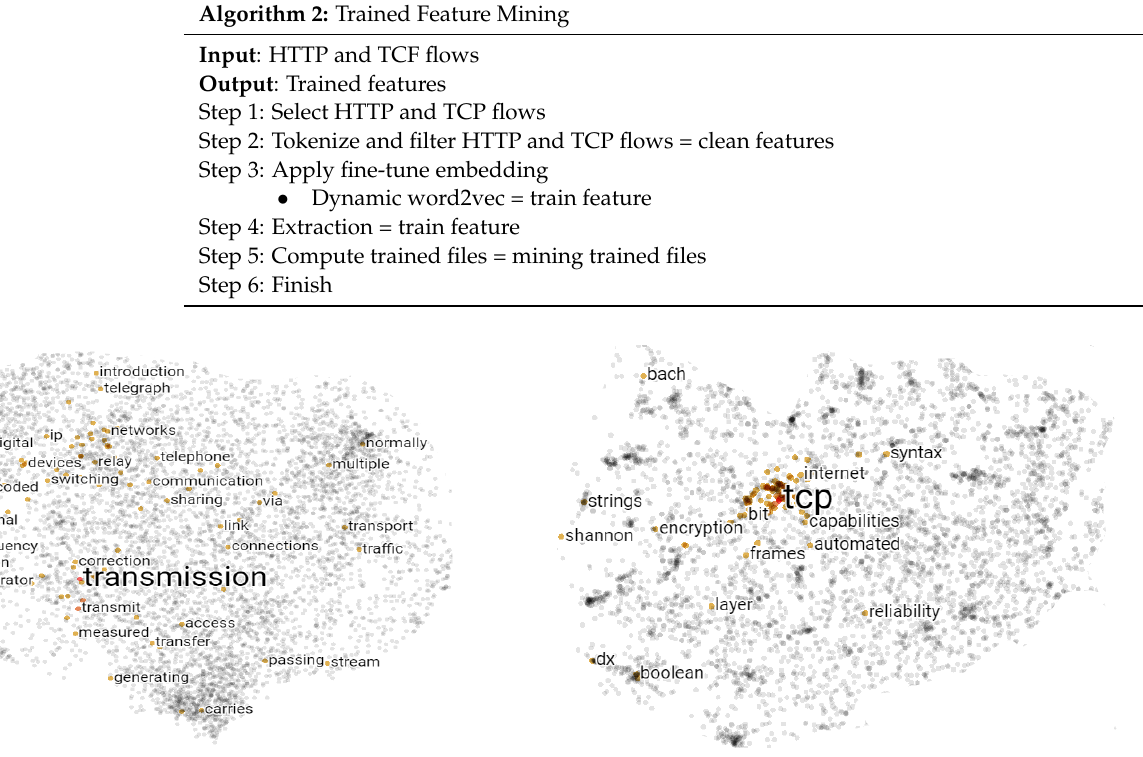
Figure 3. Visualization of trained features (transmission, tcp) using word2vec and TensorFlow.